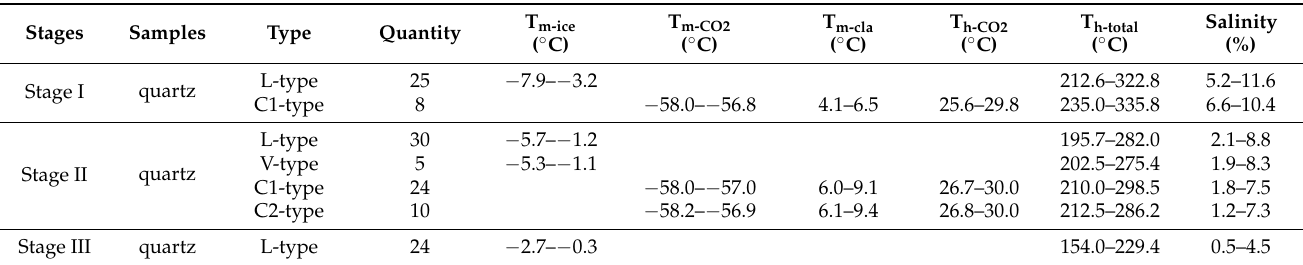
Table 1. Microthermometric data for fluid inclusions from the different hydrothermal stages in the Toudaochuan